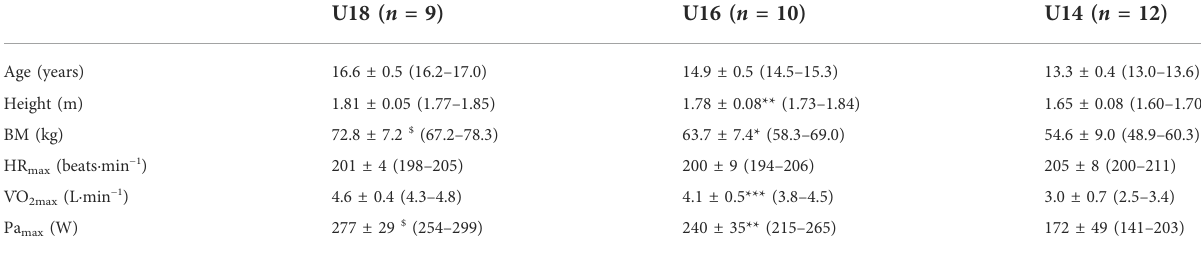
TABLE 1 Participants ’ physical characteristics in rowers under 18 years (U18), under 16 years (U16), and under 14 years (U14).